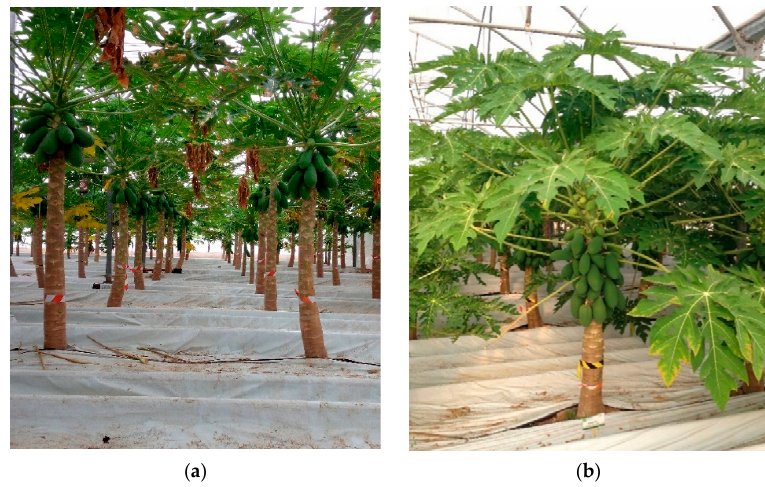
Figure 1. ‘Intenzza’ papayas planted in spring ( a ) and autumn ( b